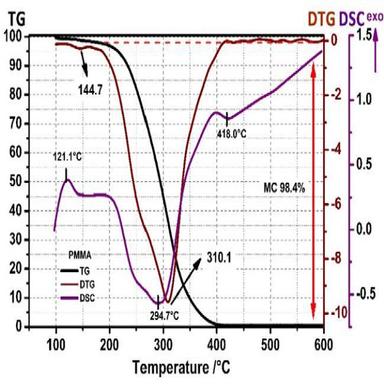
TG/DTG and DSC of PMMA.